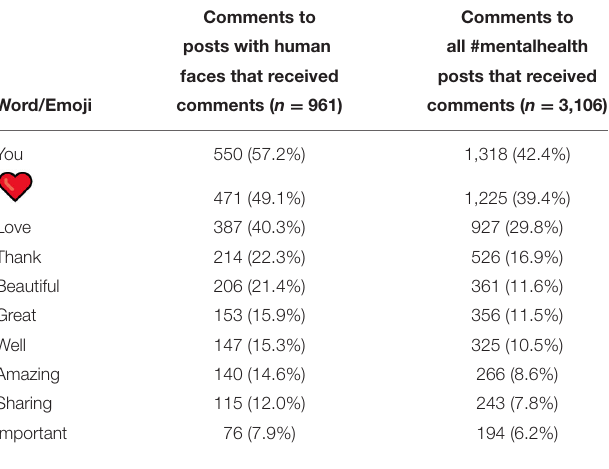
TABLE 2 | Frequency for top 10 words/emoji in comments to #mentalhealth